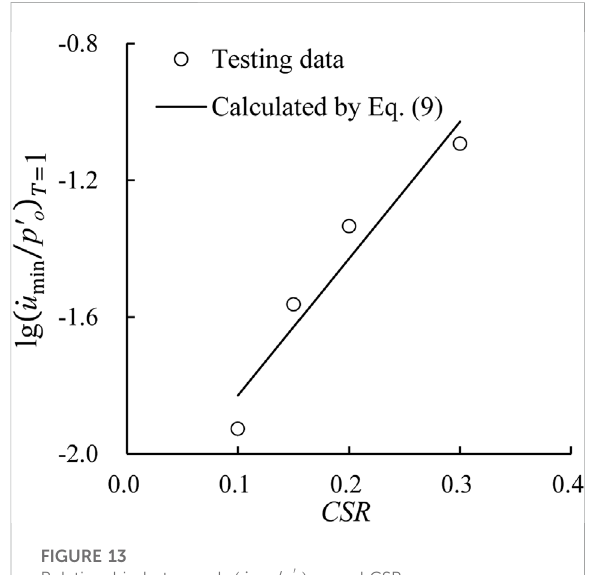
FIGURE 13 Relationship between lg ( _ u min / p ′ o ) T (cid:1) 1 and CSRs.